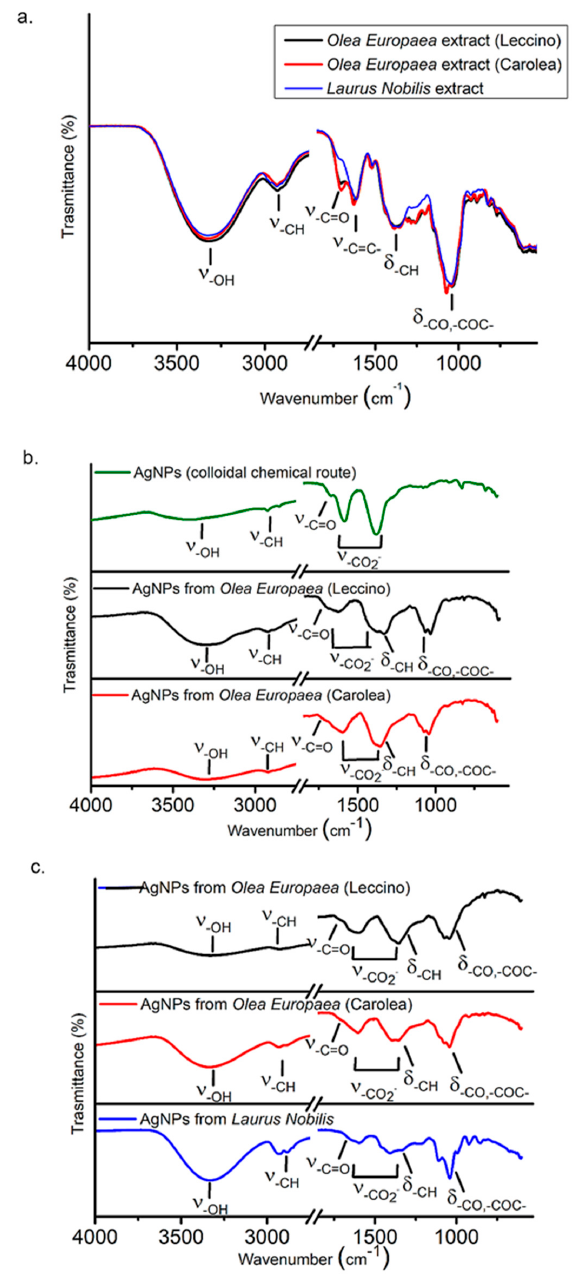
Figure 6. FTIR spectra of Olea Europaea ( Leccino and Carolea ) and Laurus Nobilis extracts ( a ), AgNPs derived from colloidal chemical routes and from green synthesis using Olea Europaea extracts ( Leccino and Carolea ) at pH 7 ( b ), AgNPs derived from green synthesis using Olea Europaea extracts ( Leccino and Carolea ) and Laurus Nobilis at pH 8 ( c ).